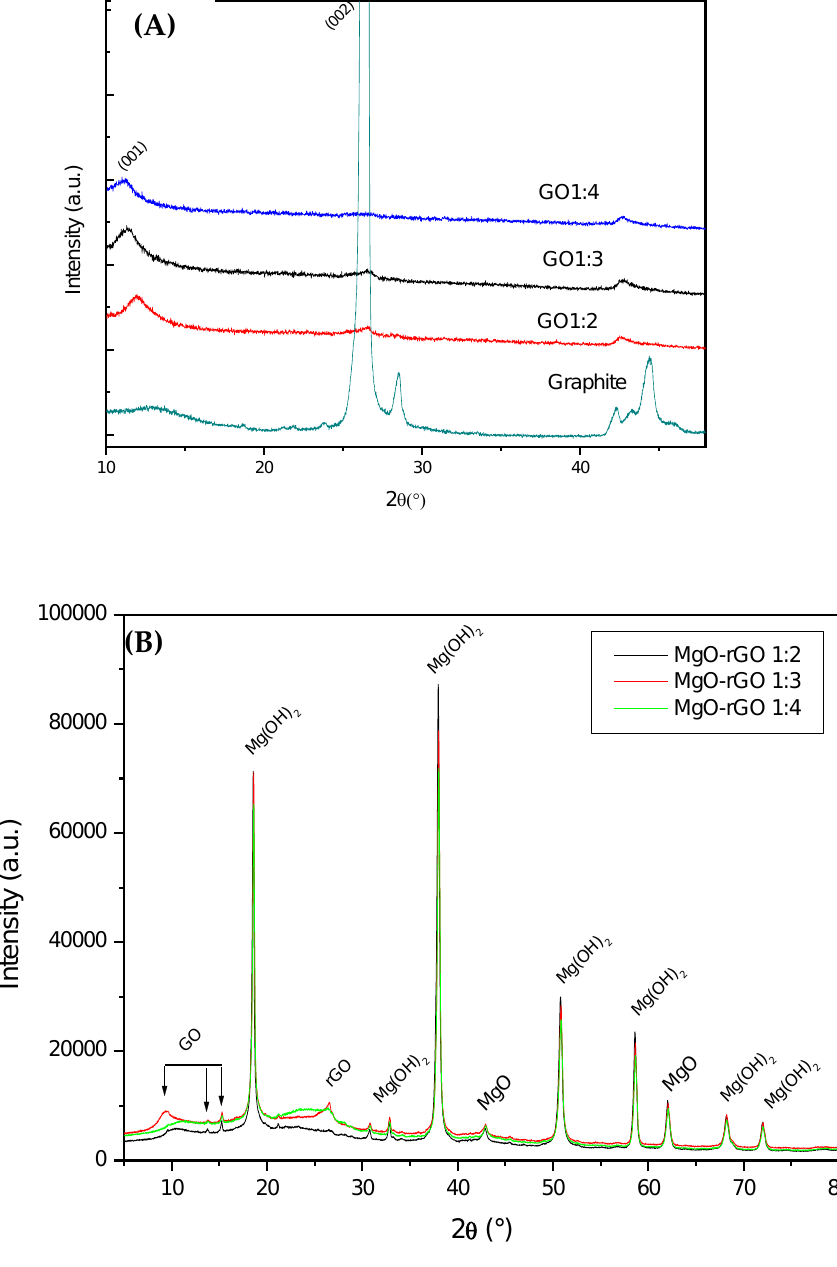
Figure 2. X-ray patterns of synthetized nanocomposites: ( A ) graphite and (GO1:2, GO1:3, and GO1:4) samples; ( B ) MgO–rGO1:2, MgO–rGO1:3, and MgO–rGO1:4 samples.